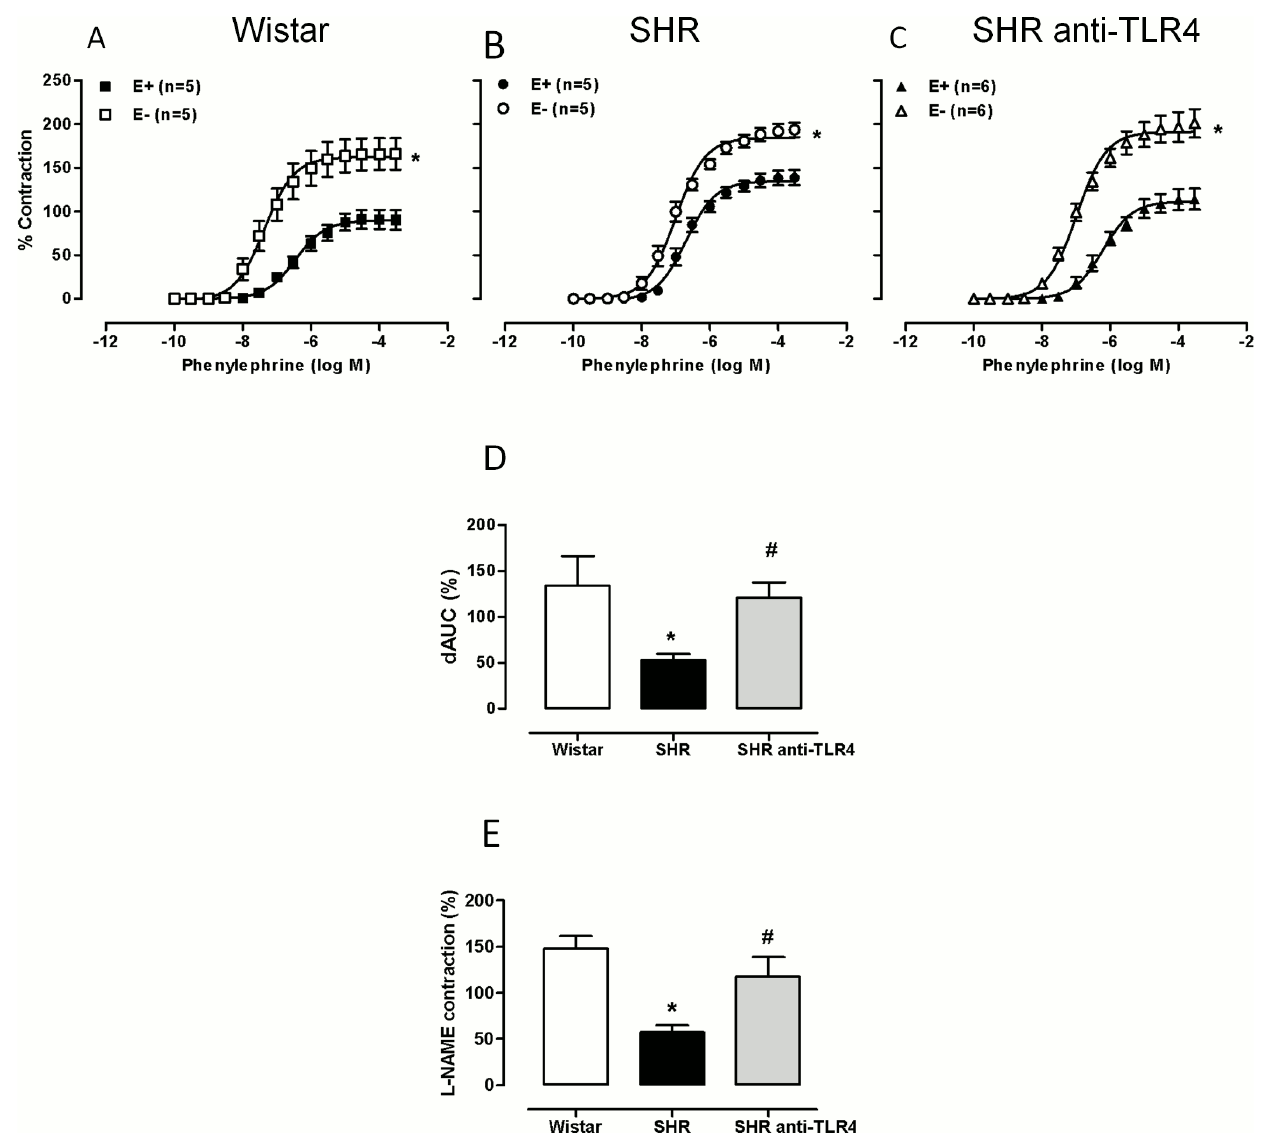
Figure 4. TLR4 inhibition increases endothelial modulation of vasoconstrictor responses. Concentration-response curves to phenylephrine in intact (E + ) and endothelium denuded (E 2 ) aortic segments from (A) Wistar and (B) SHRs treated with a non-specific IgG (1 m g/ day, 15 days) and (C) SHRs treated with anti-TLR4 antibody (1 m g/day, 15 days). (D) Differences in the area under the concentration-response curve (dAUC) in the E– and E + segments; AUC was calculated from the individual curve plots; the differences are expressed as a percentage of the AUC for the corresponding control situation. (E) Contractile response to L-NAME (100 m M) after phenylephrine (1 m M) contraction in segments from Wistar and SHRs treated with a non-specific IgG and SHRs treated with anti-TLR4 antibody; the results are expressed as the percentage of the previous contraction induced by phenylephrine. The results are the mean 6 SEM. *P , 0.05 vs. E + or vs . Wistar, # P , 0.05 vs. SHR using two-way ANOVA and Bonferroni post-test. The number of animals used is shown in